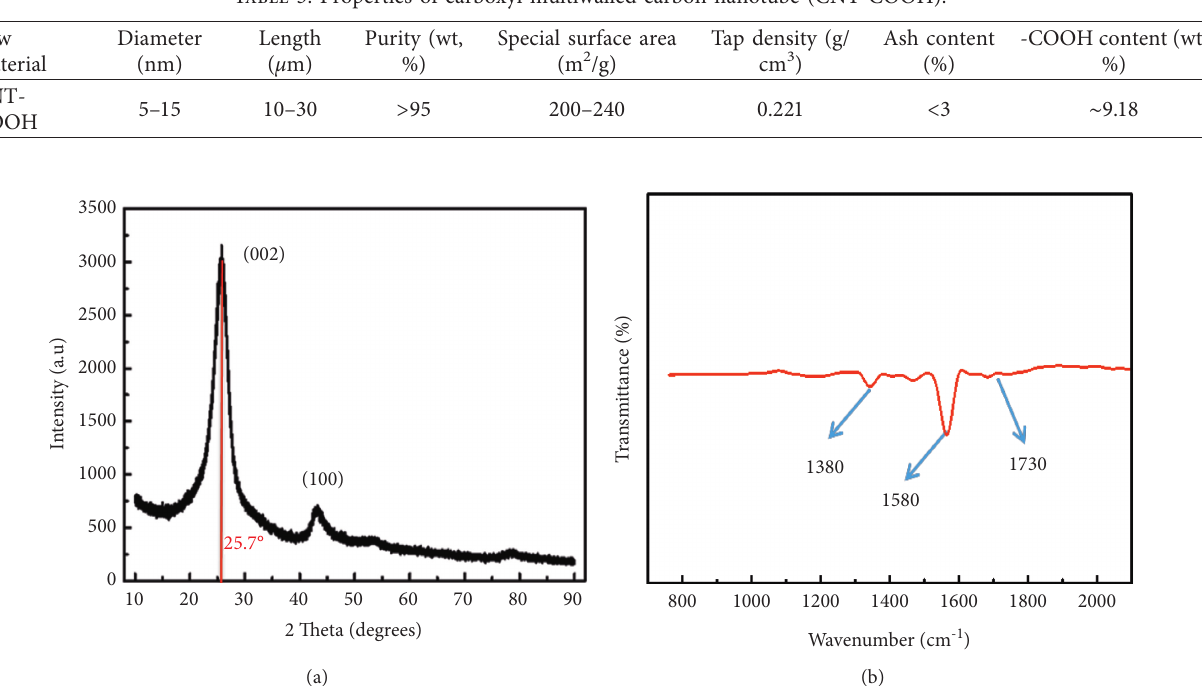
Figure 1: (a) The XRD patterns. (b) The FTIR spectra of CNT-COOH.